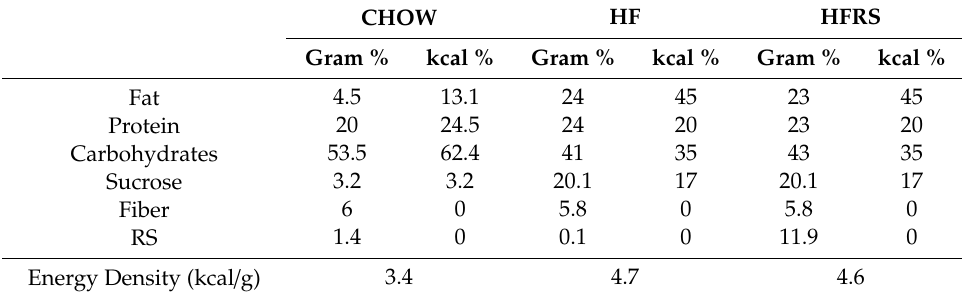
Table 1. Macronutrient composition of chow, HF, and HFRS as percent grams and energy. CHOW